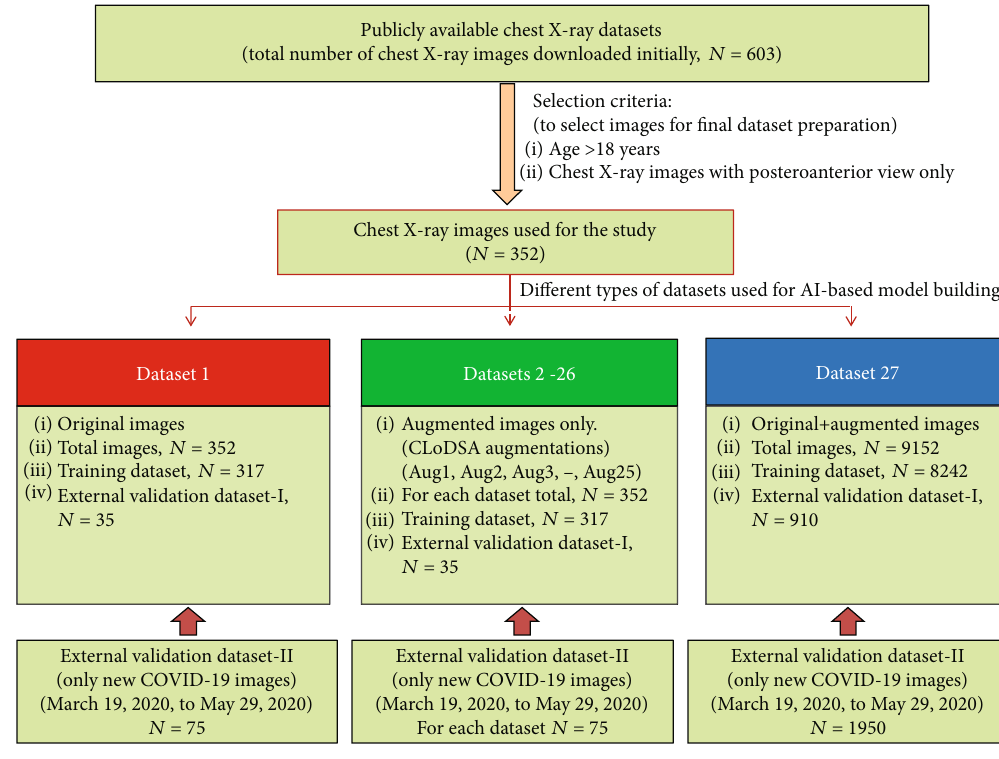
Figure 2: The methodology used for the preparation of datasets for model training and evaluation.